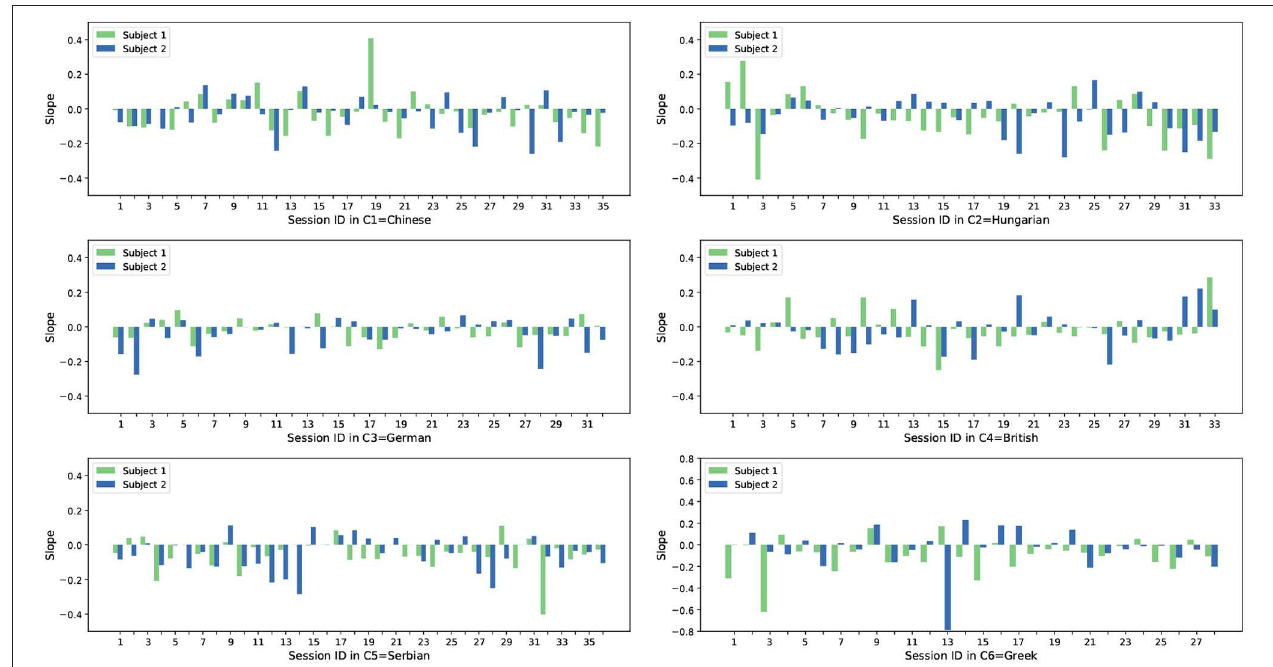
FIGURE 5 | Slope of RMSE sequences of paired subjects from all recordings in all six cultures. The results are calculated based on the DEEP SPECTRUM